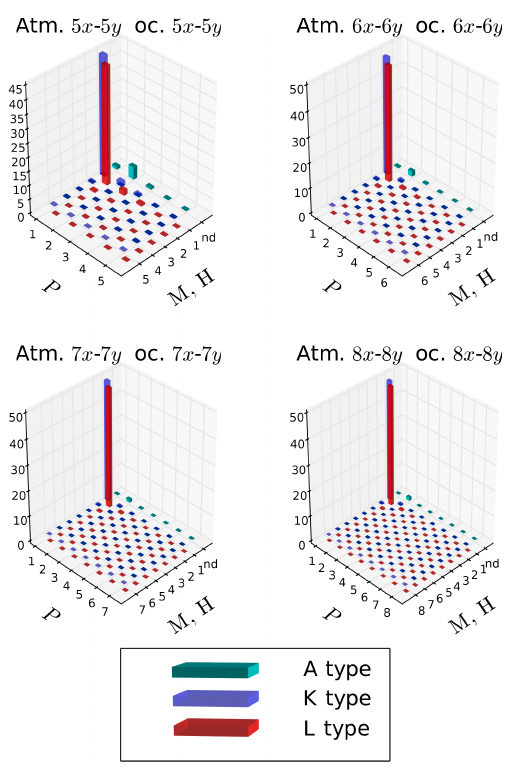
Figure 3. Variance distributions of the ψ a ,i variables in percents for various model resolutions. For the variables associated with the A - type basis functions, the wave numbers M and H are not defined (nd).